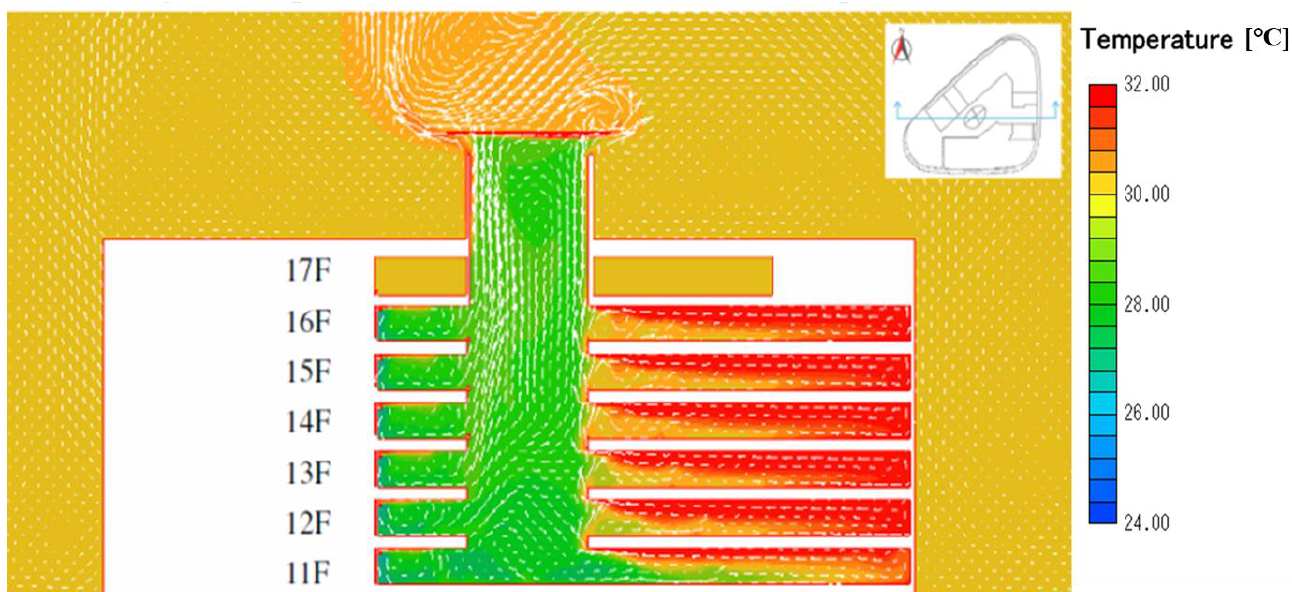
Figure 14. Temperature distribution with ambient temperature at 26 °C.